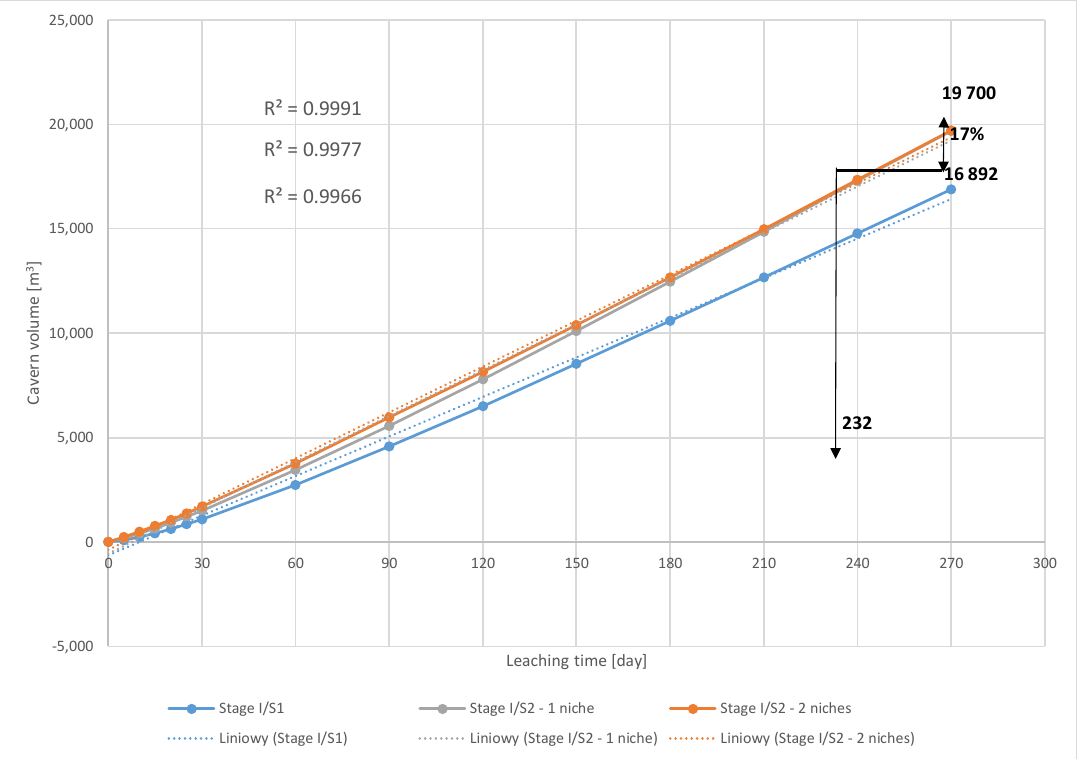
Figure 8. Comparison of the change in cavern volume for Stage I—the first 30 days for different scenarios.